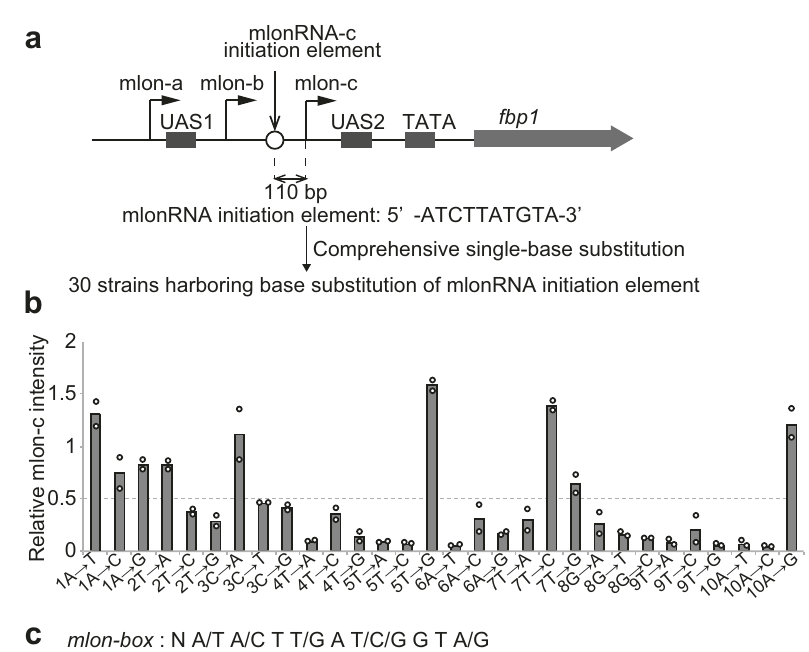
Fig. 4 Determination of a consensus sequence of mlon-IE . a Schematic representation of the fbp1 upstream region, including three distinct lncRNAs (mlonRNA-a, mlonRNA-b, and mlonRNA-c) and UAS1 and UAS2. The open circle indicates mlon-IE at 110 bp upstream from the mlonRNA-c TSS. The ten nucleotides of the mlon-IE (5 ′ -ATCTTATGTA-3 ′ ) sequence were comprehensively replaced with each of the three other nucleotides. b Relative mlonRNA-c transcript levels of indicated cells at 30 min after glucose starvation compared to wild-type cells. The band intensity of mlonRNA-c transcripts in Supplementary Fig. 6 was quanti fi ed. n = 2 biologically independent experiments. c mlon-box , a consensus sequence of mlon-IE